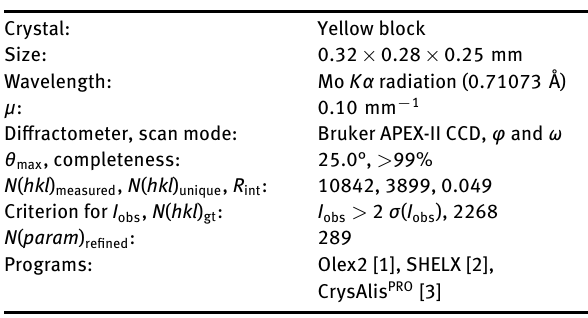
Table 2: Fractional atomic coordinates and isotropic or equivalent isotropic displacement parameters (Å 2